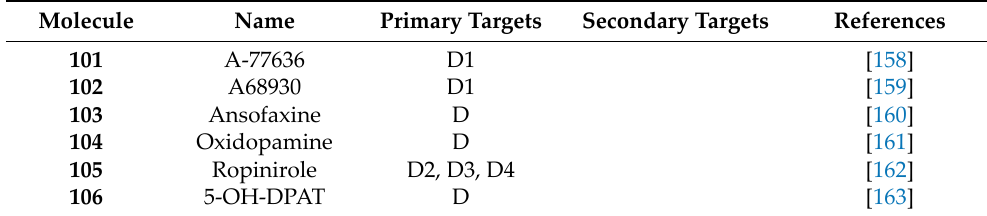
Table 4. Dopamine receptor medicinal chemistry leads.